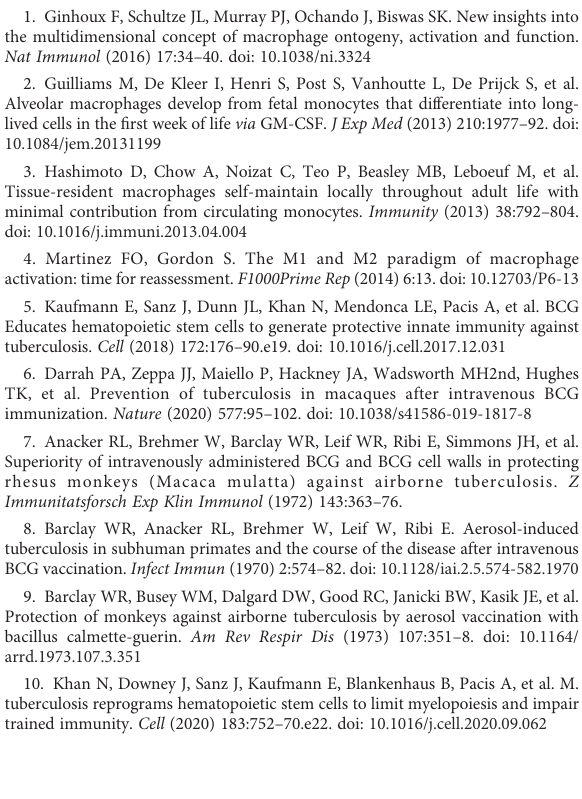
depicting the expression of CD206 as measured by fl ow